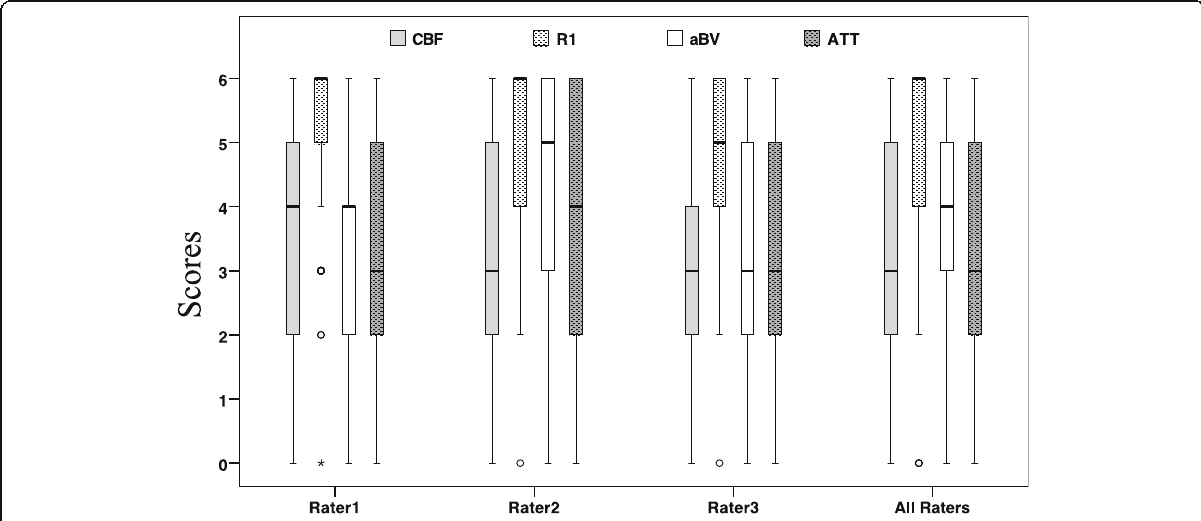
Fig. 3 Visibility scores for each of the individual raters and all the data from the three raters. The T1 relaxation rate (R1) map has the highest score, median score of 6 averaged for all raters